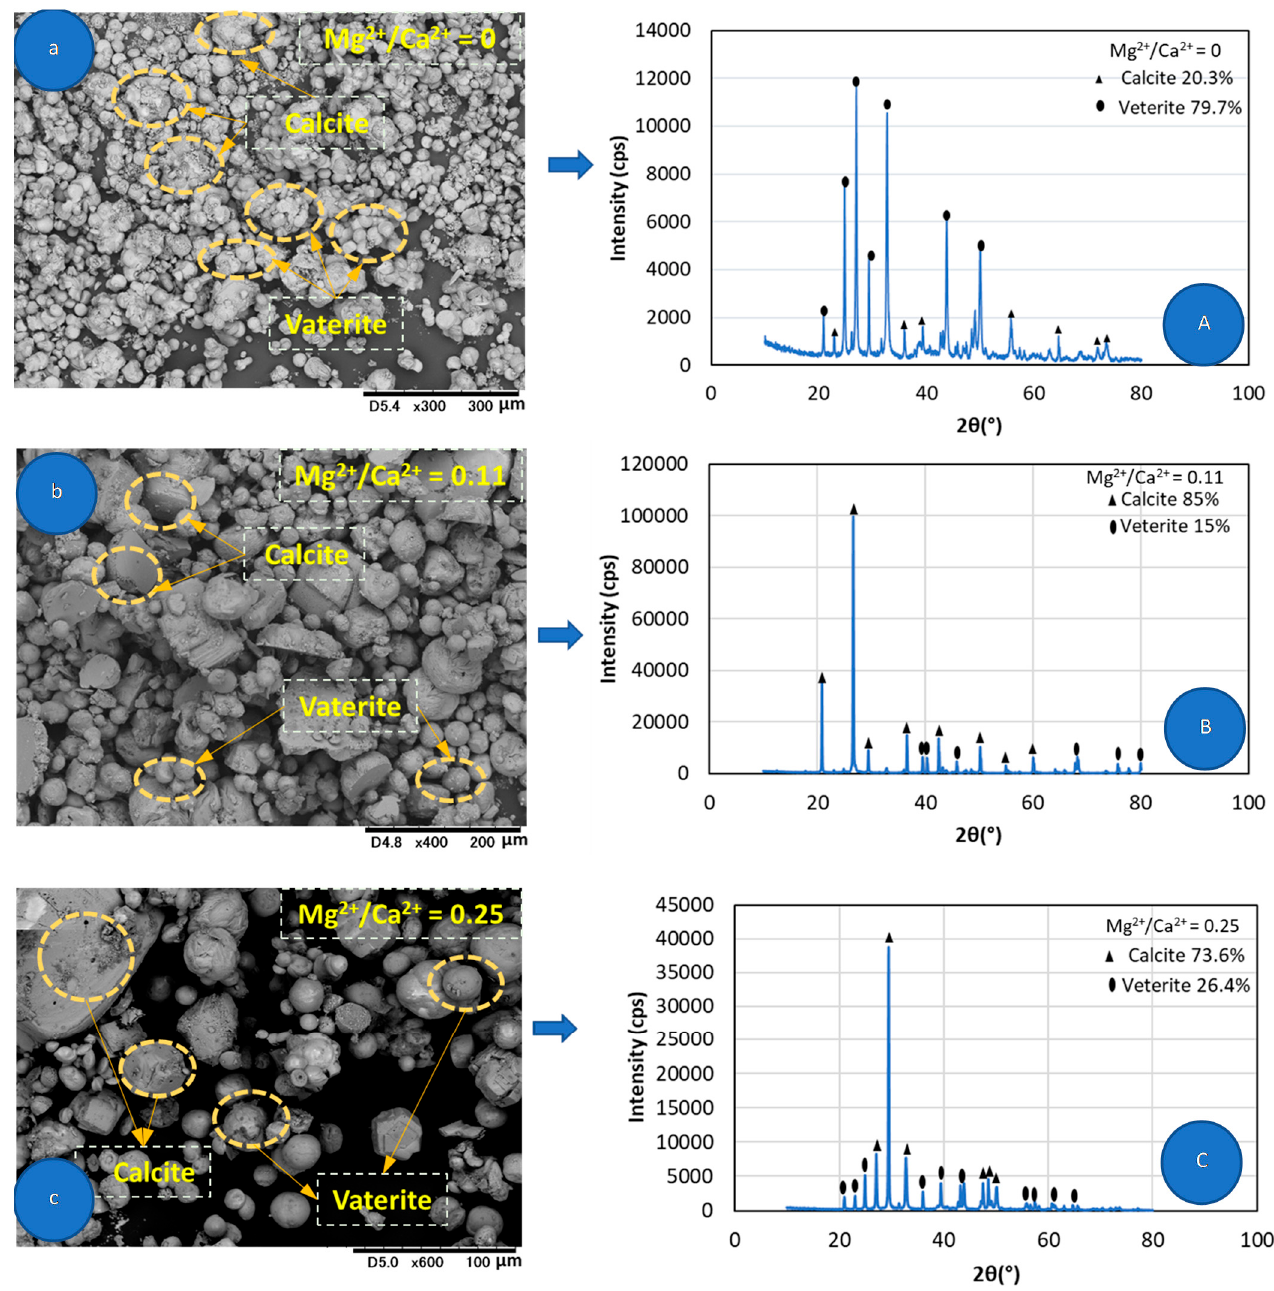
Figure 9. SEM images of the precipitated CaCO 3 crystals with different Mg 2+ /Ca 2+ ratios ( a – c ) and their subsequent XRD analysis to confirm the polymorph of the crystals ( A – C ).